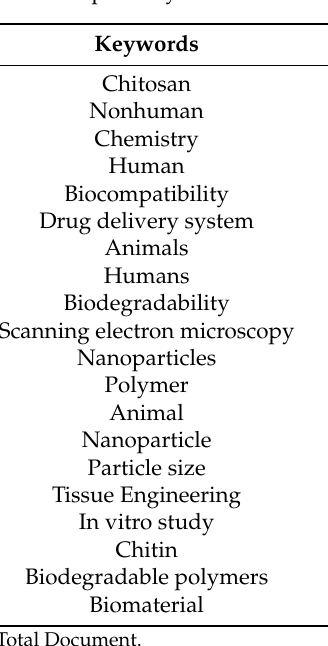
Table 8. Top 20 Keywords with Total Link Strengths.